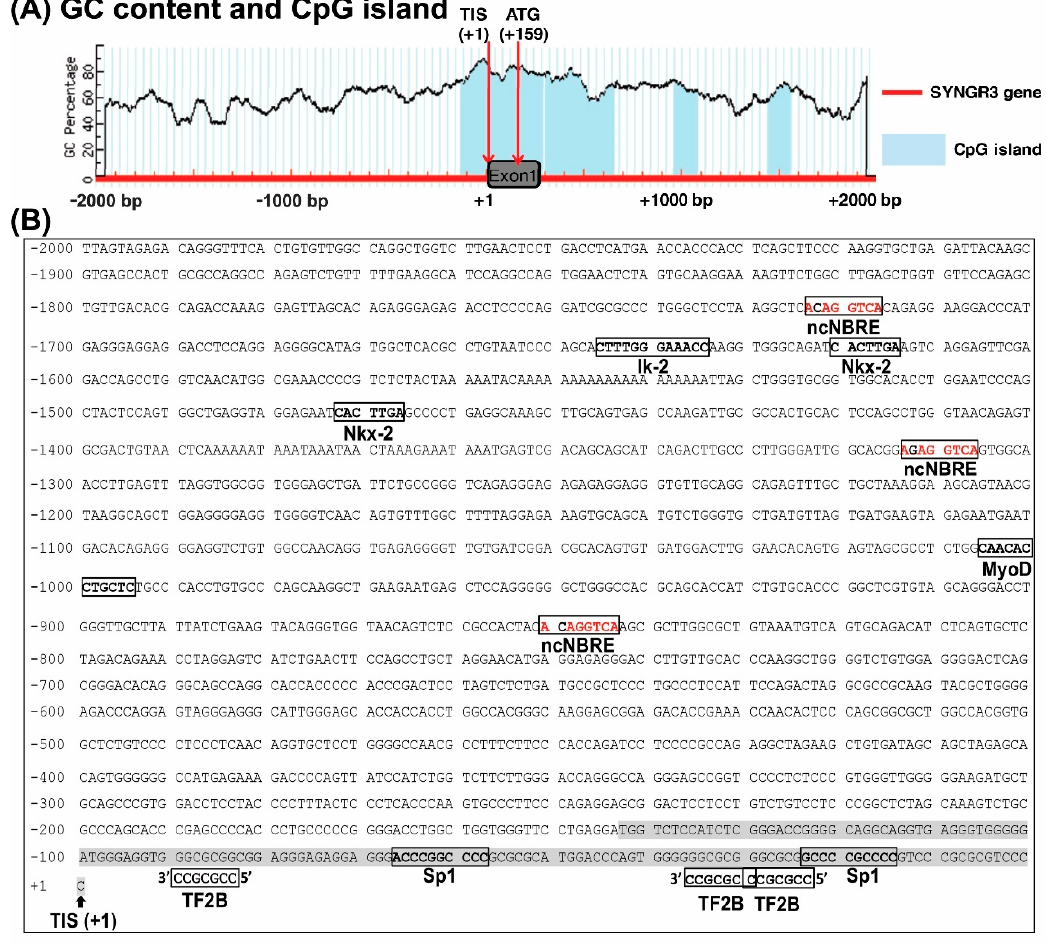
Figure 2. Characterization of the 2000 bp 5 ′ -flanking region of the human SYNGR3 gene. ( A ) Analysis using the MethPrimer program (http://www.urogene.org/methprimer/; accessed on 1 March 2019) revealed four CpG islands located at − 143/+289, +305/+654, +962/+1085, and +1448/+1554 relative to the published TIS of human SYNGR3. Blue areas indicate potential CpG islands (island size > 100 bp, GC% > 50%, observed-to-expected CpG ratio > 0.6). Red arrows indicate TIS and ATG sites. ( B ) Genomic DNA sequence and putative transcription factor binding sites in the vicinity of 2000 bp upstream to 200 bp downstream of TIS of the SYNGR3 gene.